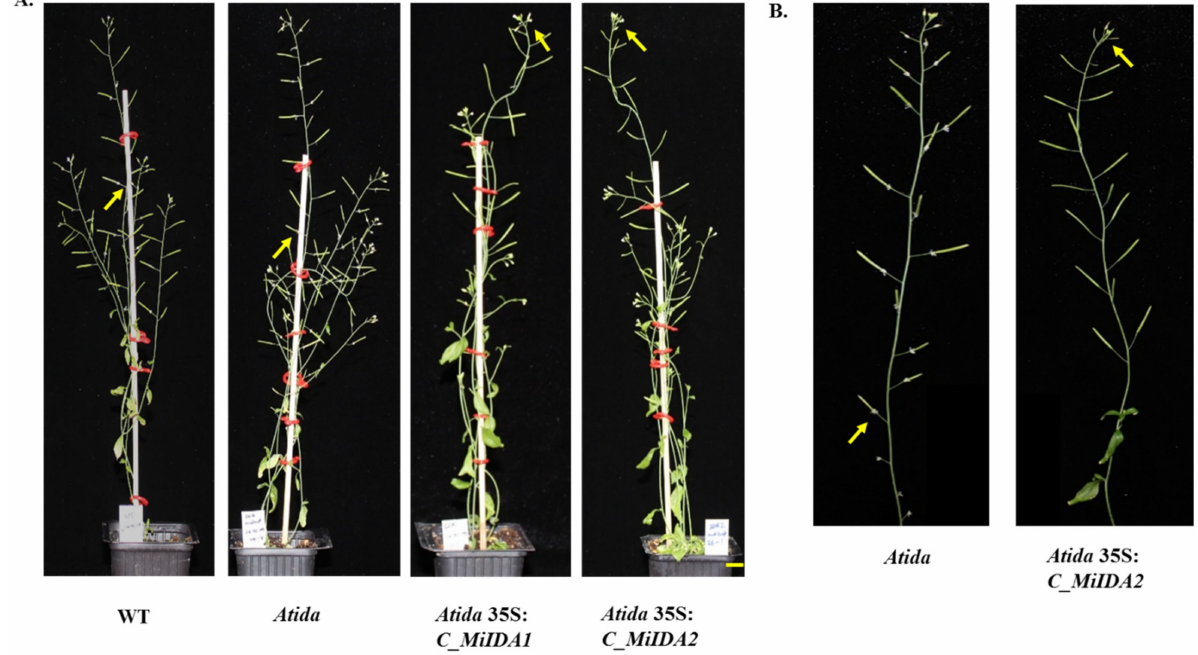
Figure 7. MiIDA1 and MiIDA2 , expressed under control of the 35S promoter, complemented and restored floral organ abscission ability in an Atida mutant. Phenotypes of fully developed WT, Atida mutant, Atida 35S: C_MiIDA1- and Atida 35S: C_MiIDA2 -complemented plants ( A ), and enlarged photos of the Atida mutant and Atida 35S: C_MiIDA2 -complemented plants ( B ), are presented. Scale bar = 1 cm. Arrows denote attached floral parts.